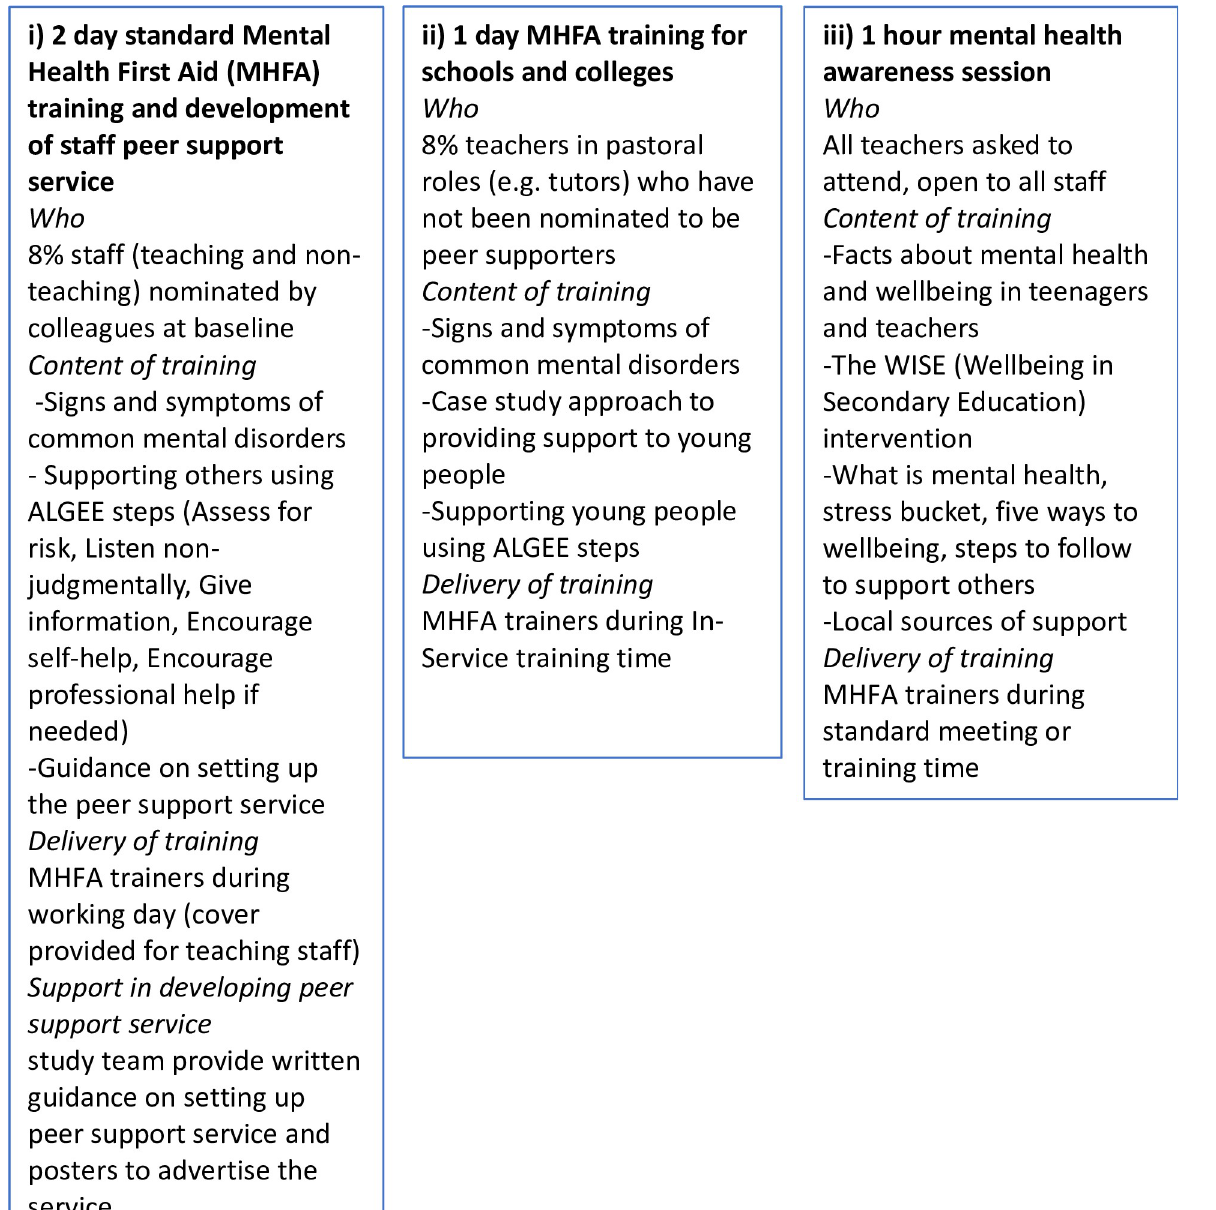
Fig 2. Intervention delivery. ALGEE, Assess for risk, Listen nonjudgmentally, Give information, Encourage self-help, Encourage professional help if needed; MHFA, Mental Health First Aid; WISE, Well-being in Secondary